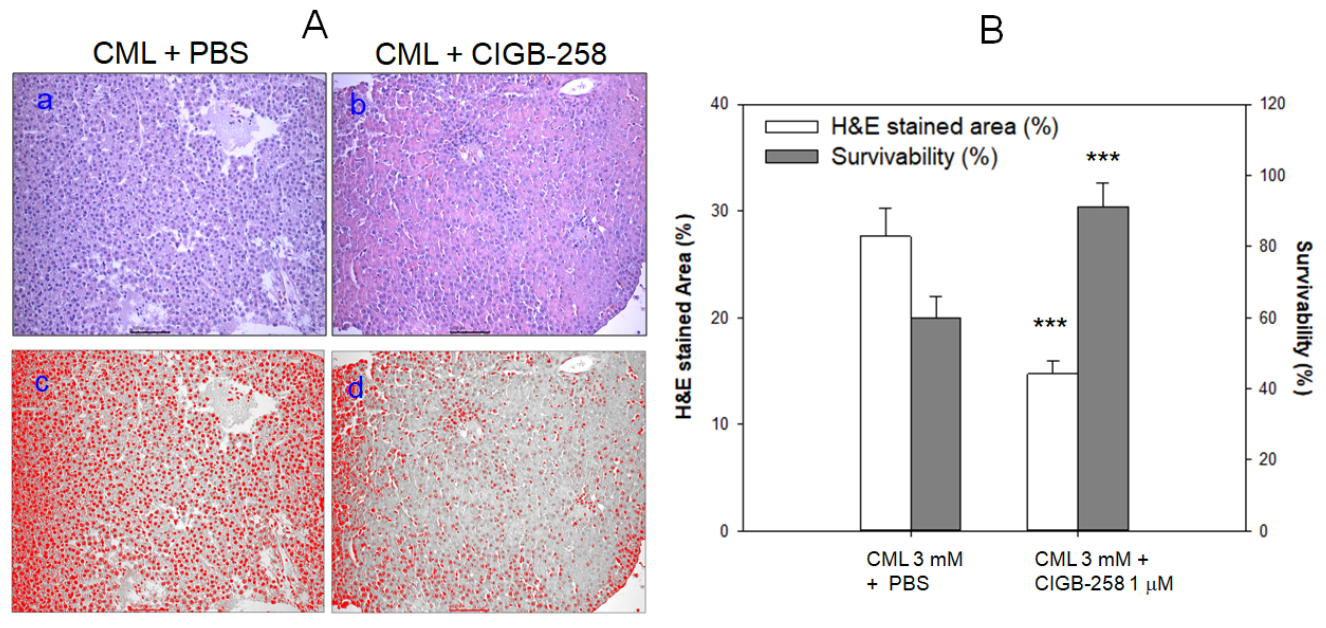
Figure 6. Histologic analysis and survivability of zebrafish injected with carboxymethyllysine (CML) in the presence or absence of CIGB-258. ( A ) Visualization of the infiltration of neutrophils by Hematoxylin and Eosin (H&E) staining as shown in top photographs (photo a and b, 400× magnification). The bottom photographs show conversion of the Hematoxylin-stained area into red intensity (photo c and d, 400× magnification). ( B ) Quantification of the nucleus area from H&E staining using Image J software (http://rsb.info.nih.gov/ij/, accessed date 15 April 2022) as shown in red intensity and survivability of zebrafish at 60 min post-injection. ***, p < 0.001 versus CML + PBS.